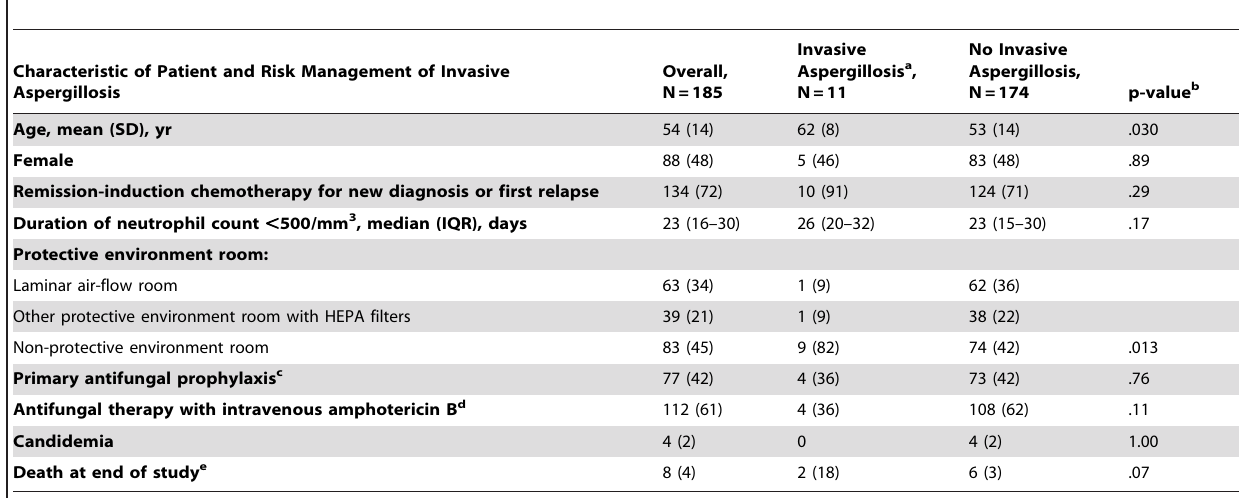
Table 1. Characteristics of 185 febrile, neutropenic patients treated for acute myeloid leukemia and by invasive aspergillosis.